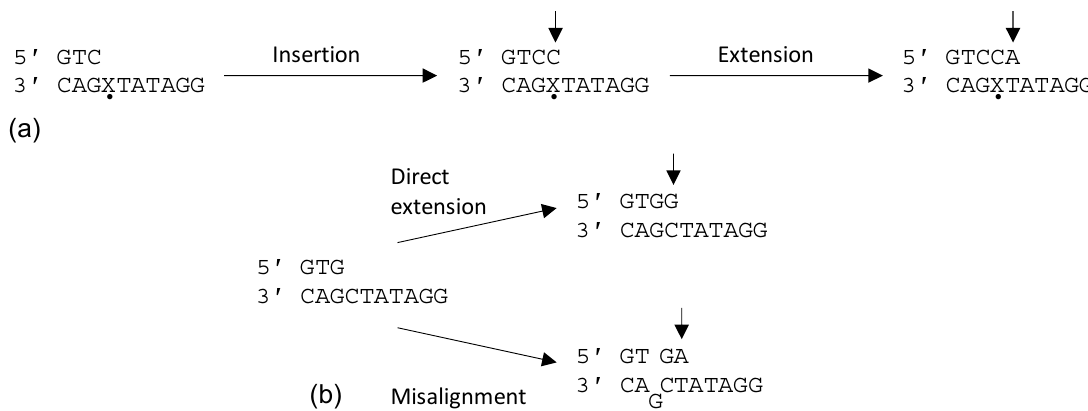
Figure 1. ( a ) Primer extension by translesion synthesis showing both the insertion and extension steps. The dot indicates the site of a lesion. ( b ) Direct extension (top) versus a one-nucleotide deletion resulting from looping a template base out of the DNA helix.